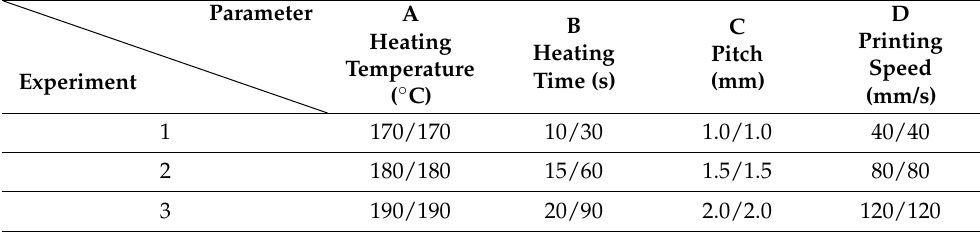
Table 2. Level of processing parameters applied for deformation recovery.